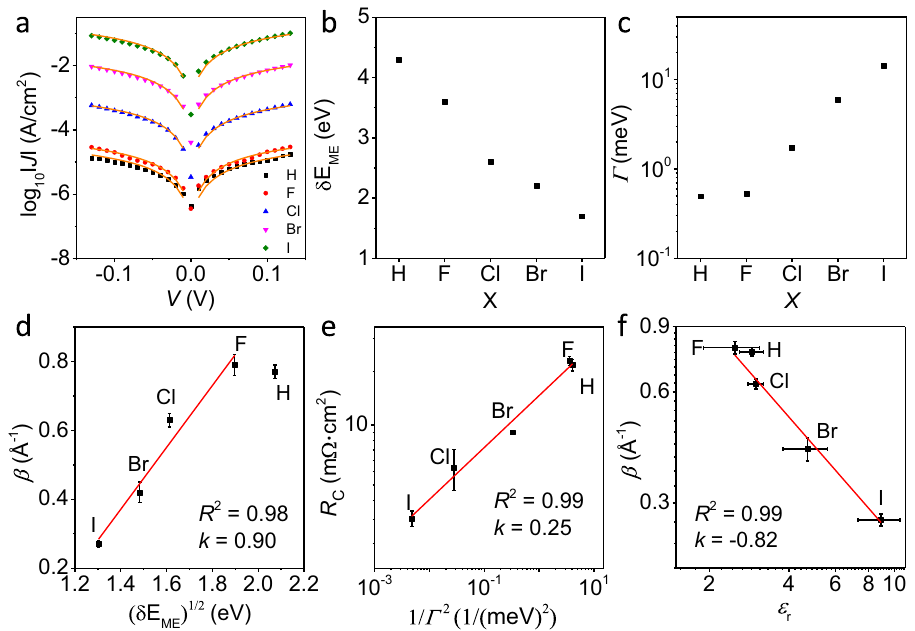
Fig. 6 Single-level Landauer model analysis. a The modelled current through the Ag – S(CH 2 ) 14 X//GaO x /EGaIn junctions using Landauer theory (orange solid lines are Landauer fi ts, symbols represent experimental data). The values of tunnelling barrier height ð δ E ME Þ ( b ) and the coupling strength ð Γ Þ ( c ) used for modelling the current through the junctions. d Tunnelling decay coef fi cient β vs. deviations of the β values from linear fi ts to Eq. (1). e Double - log plot of R C vs. 1/ Γ 2 ( R C represents contact resistance) where the red line is a power-law fi t with a slope of 0.25 and R 2 = 0.99, error bars of R C represent the standard deviations of three independent measurements. f Double-log plot of β vs. ε r where the red line is a fi t with a slope of − 0.82 and R 2 = 0.99. The error bars of β represents the same as panel b , and of ε r represent the standard deviations of three independent